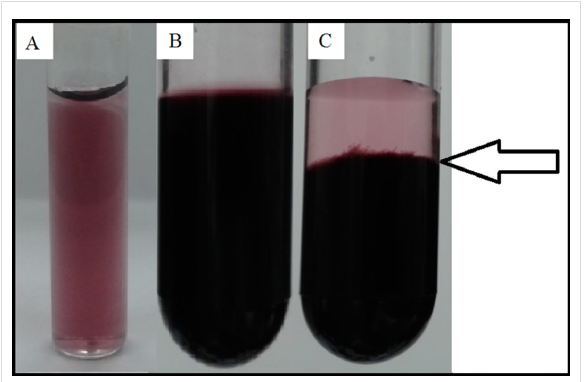
Figure 3: Binding of CR to SWNTs in solutions of different ionic strength. All samples were in a 0.05 M Tris-HCl pH 7.4 buffer with: 1) no NaCl; 2) 0.145 M NaCl; 3) 0.264 M NaCl. The amount of CR added to the nanotube portion was taken as 100%.